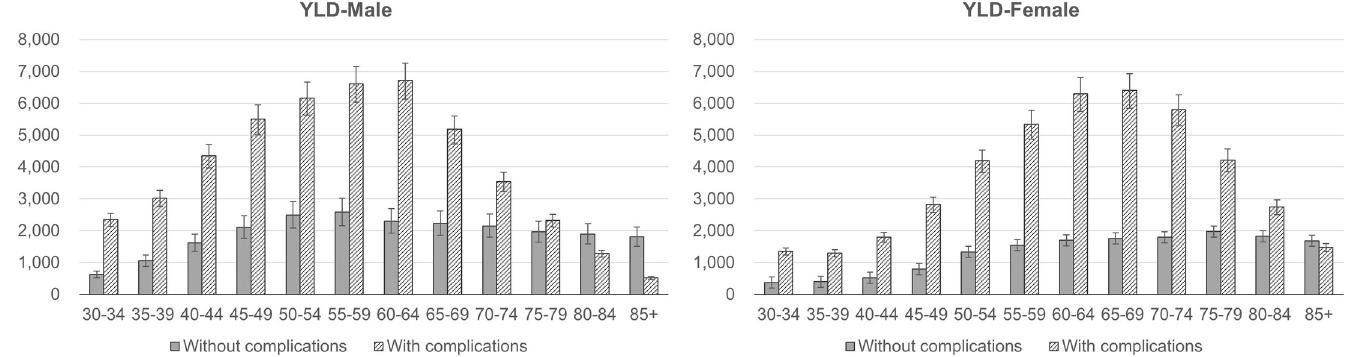
Fig 4. Estimated YLDs per 100,000 population depending on complications. YLDs, years lived with disability. Unit: YLDs per 100,000 population.